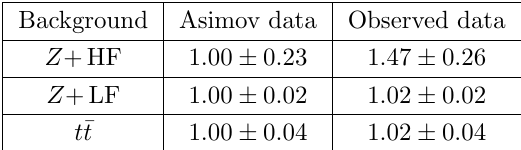
Table 1 . Normalization factors of the dominant backgrounds as measured in a (cid:12)t to data under the background plus signal hypothesis (480 GeV bb (cid:8) signal). The uncertainty includes both the statistical and systematic sources: the latter ones dominate. The reduction of the observed relative uncertainty of the Z + HF normalization in the data (cid:12)t is due to the large increase in the number of Z + HF events when the data in signal regions are